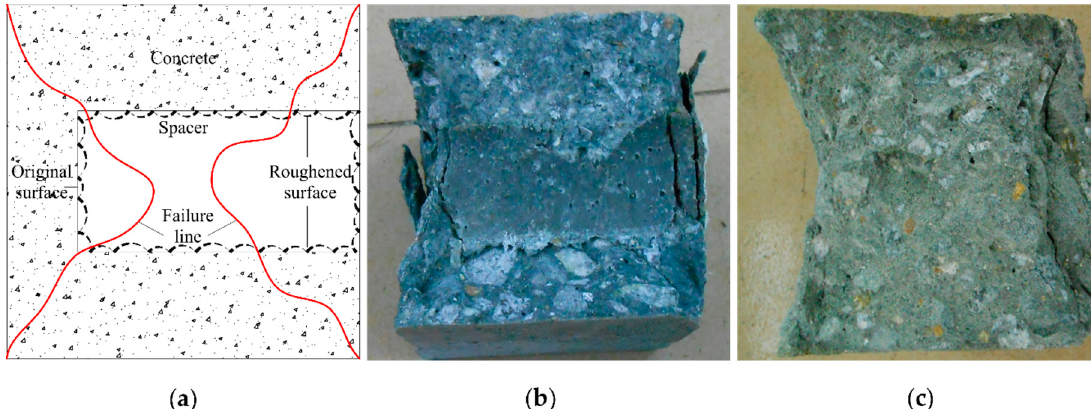
Figure 5. Failure modes of the spacer and concrete composite specimens after the compressive strength testing: ( a ) the theoretical failure mode of the spacer and concrete composite specimen, where the red line indicates the expected cracking pattern; ( b ) the composite specimen without surface treatment (N); and ( c ) the composite specimen with surface treatment (T).